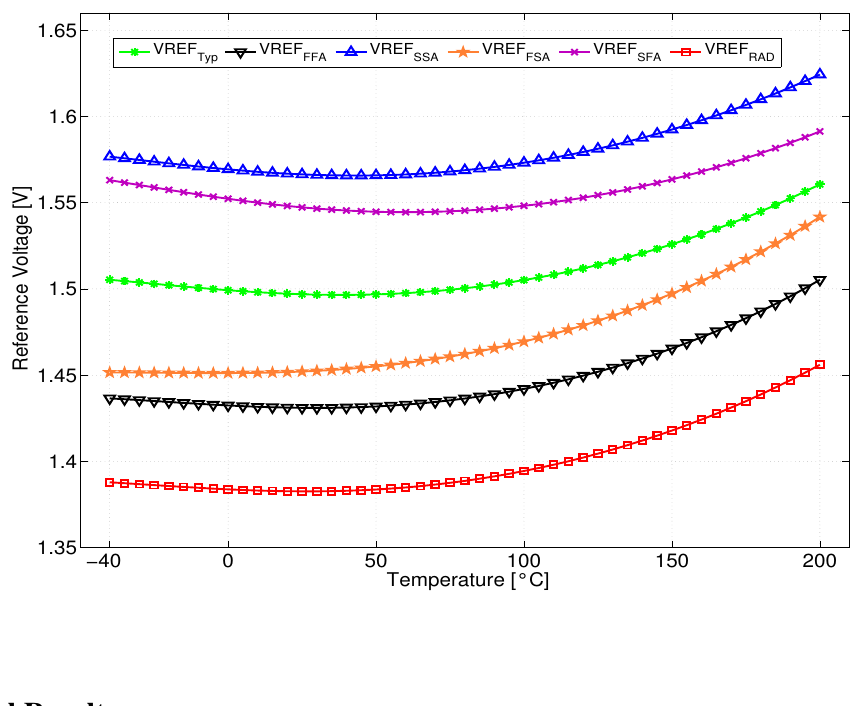
versus temperature and process REF